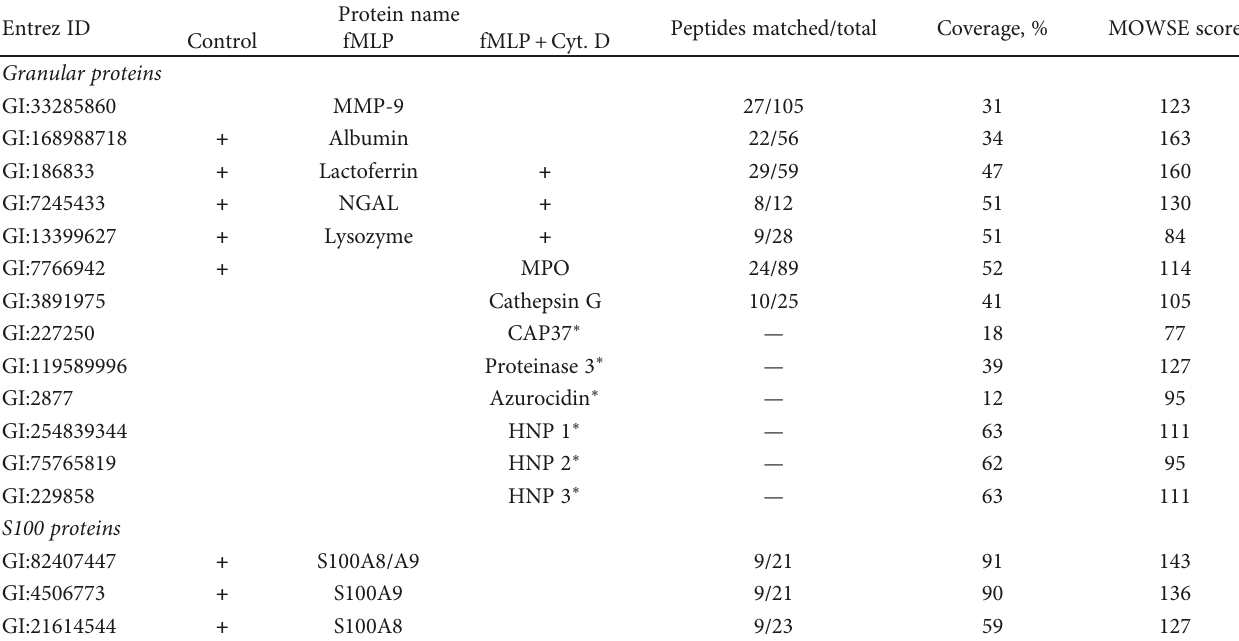
Table 1: A list of proteins that were secreted by neutrophils into the extracellular medium during a 20 min incubation with fi bronectin-coated substrata under control conditions, in the presence of 1 μ M fMLP alone or in the presence of both 1 μ M fMLP and 10 μ M cytochalasin D (fMLP+Cyt. D). Mass spectrometric analysis data were taken from experiments with fMLP. Analogous proteins that were identi fi ed in control experiments or in experiments with fMLP +Cyt. D are marked ( + ). Mass spectrometric data for proteins that were identi fi ed upon fMLP +Cyt. D treatment were taken from these experiments. Proteins were separated by SDS-PAGE and identi fi ed by mass spectrometric analysis. ∗ Protein was identi fi ed by MSMS analysis. Proteins identi fi ed in two or three analogous experiments were included in the